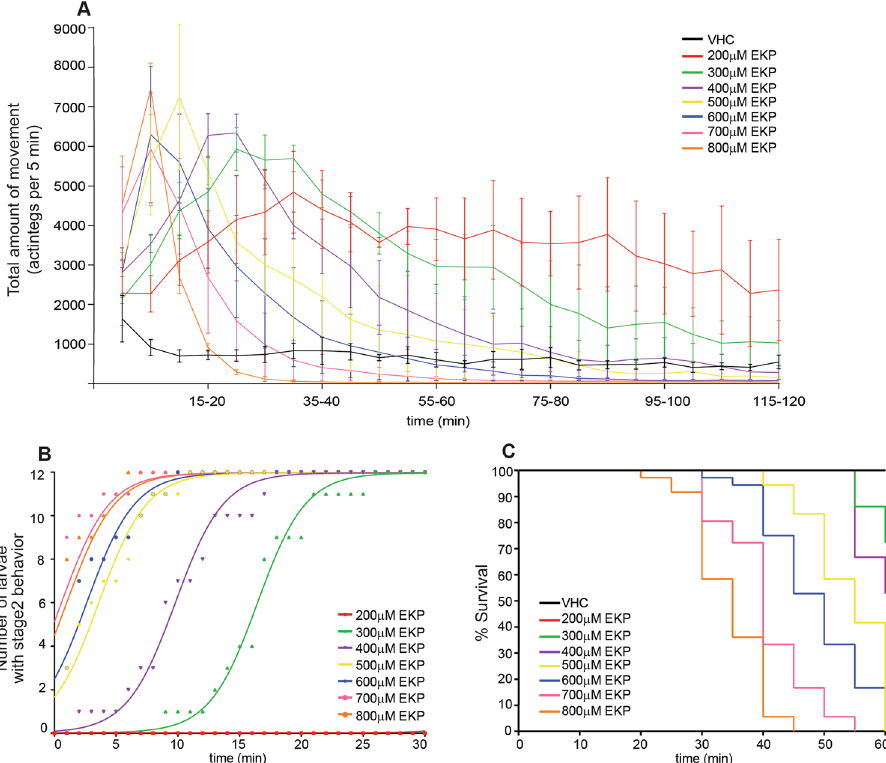
Figure 2. Behavioral profile of zebrafish larvae exposed to EKP. ( A ) Locomotor behavior of 7 dpf larvae treated with EKP (200 μ M–800 μ M) as compared to VHC-treated larvae. The data on the Y-axis refer to the average total movement of larvae per 5-minute (min) intervals. Results shown were pooled from four independent experiments with 12 larvae per experiment that were individually analyzed. Error bars represent s.d. ( B ) Phase 2 seizure-related behavior observed in zebrafish exposed to EKP. Zebrafish larvae at 7 dpf were incubated with medium containing 200 μ M–800 μ M EKP for 30 min. The total number of larvae displaying phase 2 behavior was added up per minute interval. Each group represents a total of 12 larvae. ( C ) Kaplan-Meier cumulative survival curve of 7 dpf larvae during exposure to 200 µ M–800 μ M EKP or VHC (n = 36 for each